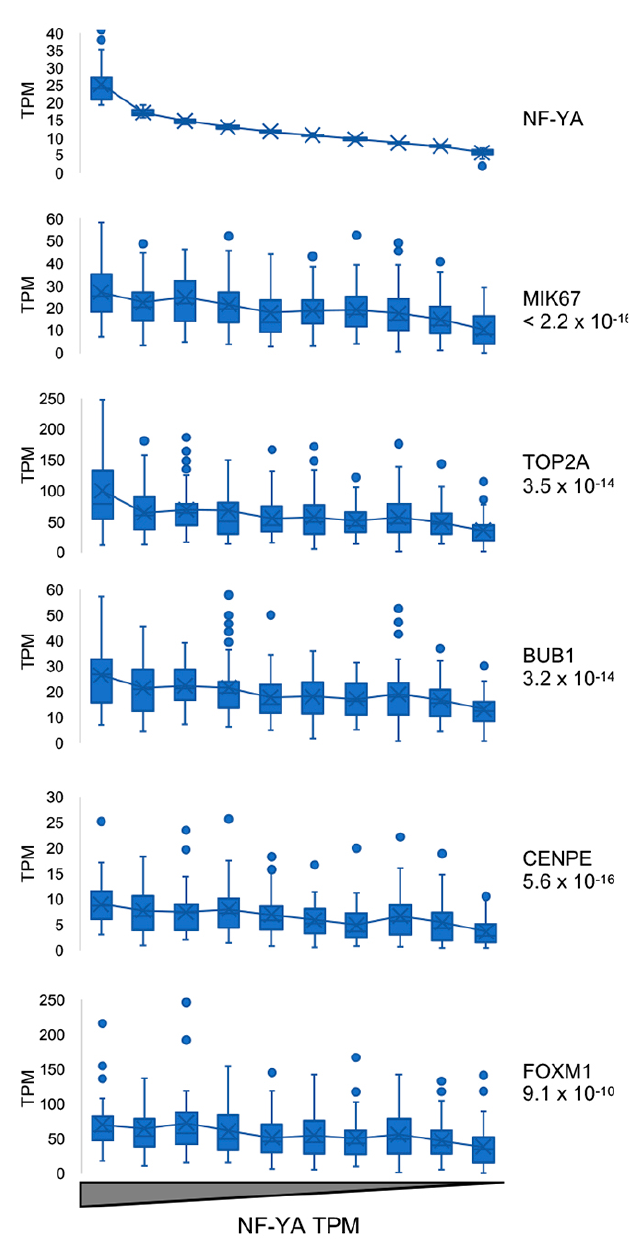
Figure 3. TCGA-LUSC samples ranked based on NF-YA expression. Upper panel, separation of LUSC samples in ten bins of NF-YA expression levels, according to TPM values. Lower panels, expression of Ki67 (MIK67), TOP2A, BUB1, CENPE and FOXM1.